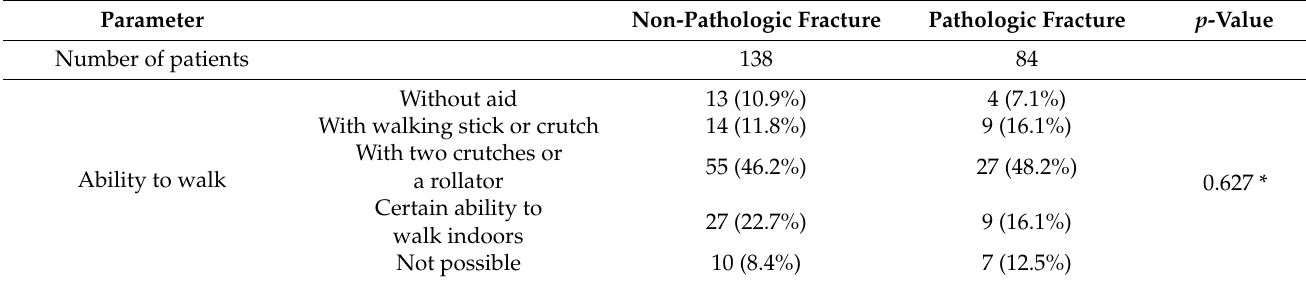
Table 5. Univariable analysis of a 2:1 optimal propensity score matching analysis of 120-day follow-up data on geriatric trauma patients with hip fractures depending on the kind of fracture